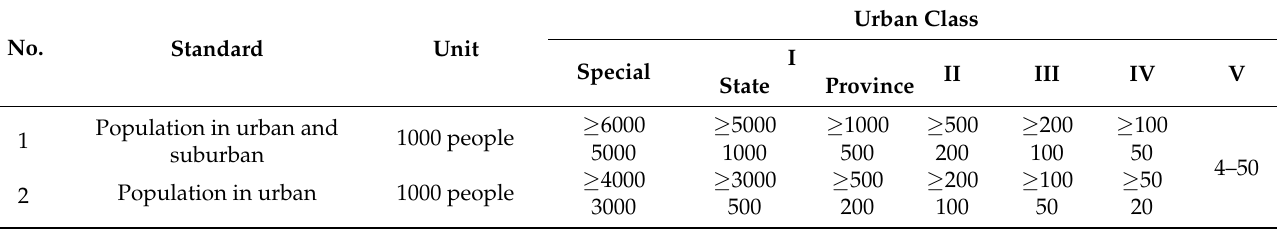
Table 1. Population scale standard